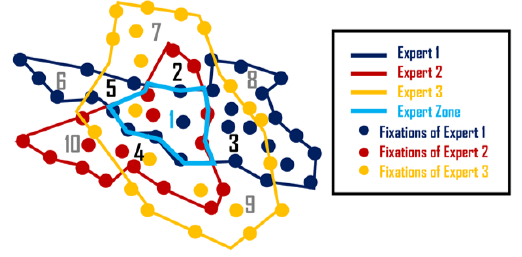
Figure 1: Example of how expert zone established in three-expert